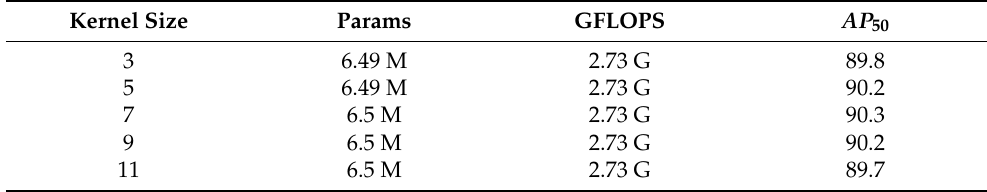
Table 4. Ablation study of spatial attention module kernel size in ECBAM. Kernel size represents the kernel size of convolution layer used in the spatial attention module in ECBAM.